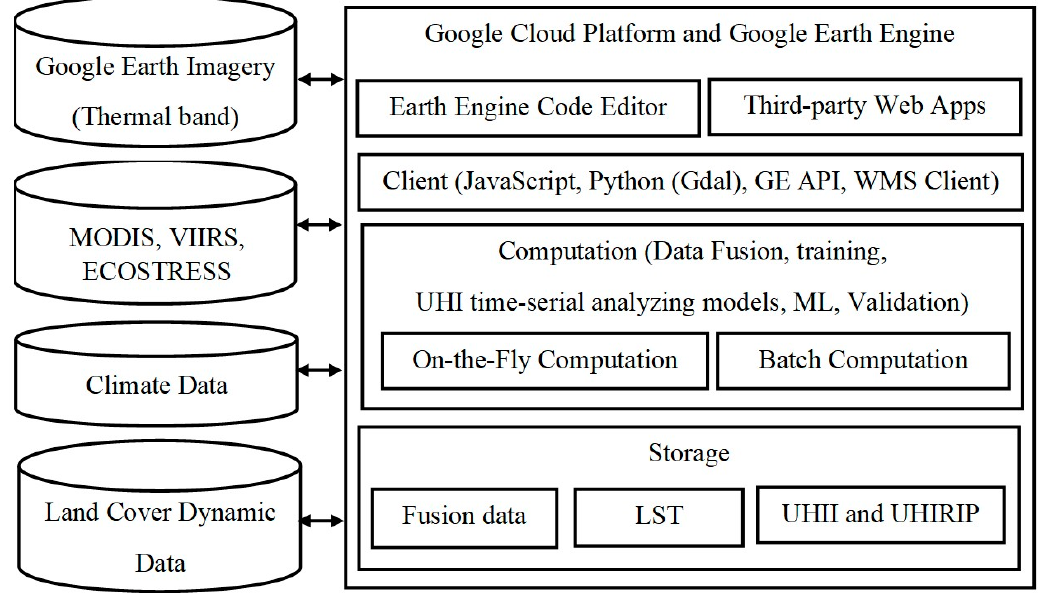
Figure 5. Simplified system diagram using the Google Cloud platform and Google Earth engine for monitoring UHI and UHIRIP.